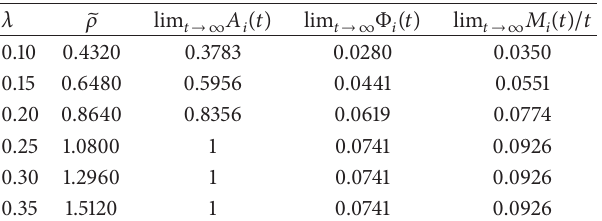
Table 4: The effects of unpredictable events arrival rate 𝛼